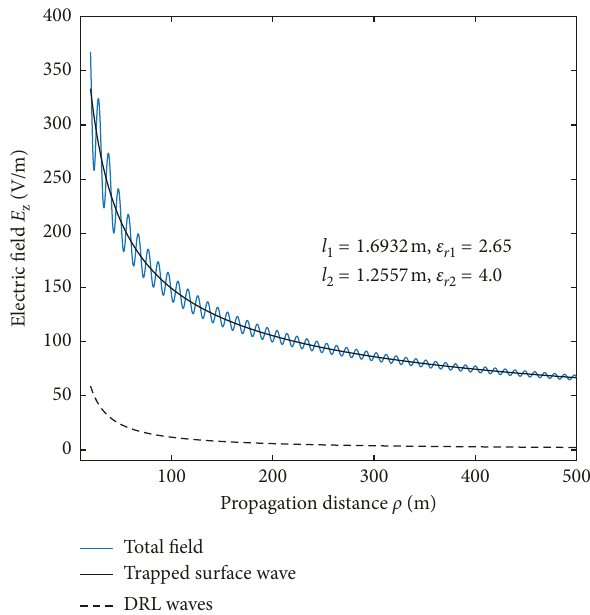
Figure 7: The electric component | E field due to a vertical dipole on the conductor coated by two di- electric